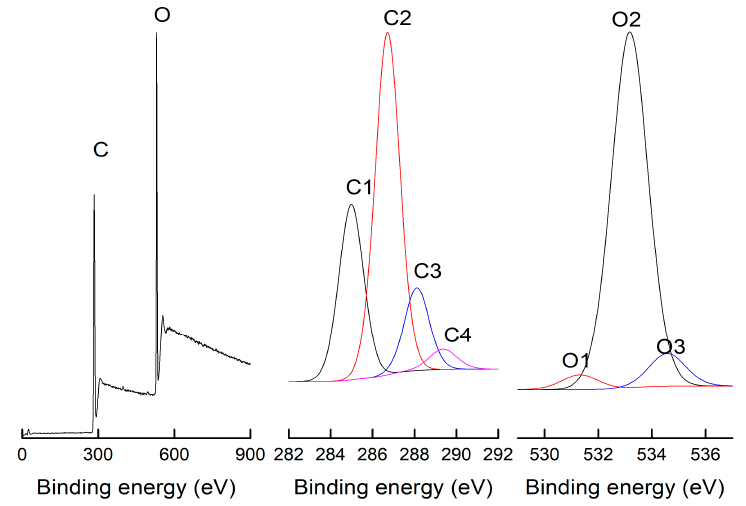
Figure 2. Typical X-ray photoelectron spectroscopic survey spectra of the control sugar maple wood.